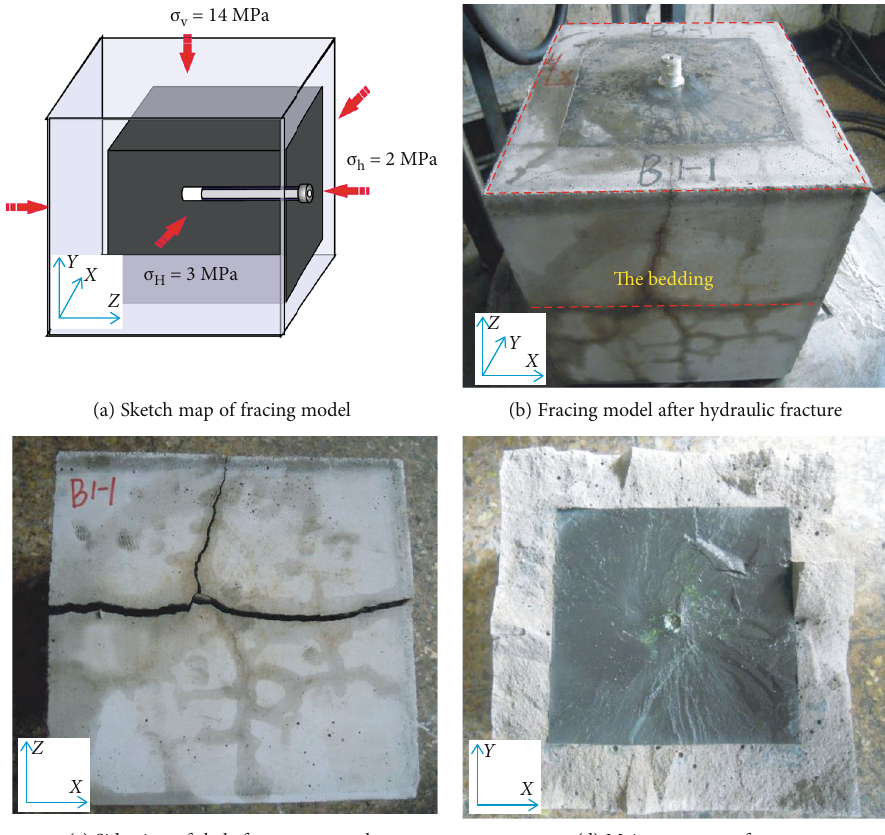
Figure 10: Failure patterns of specimen